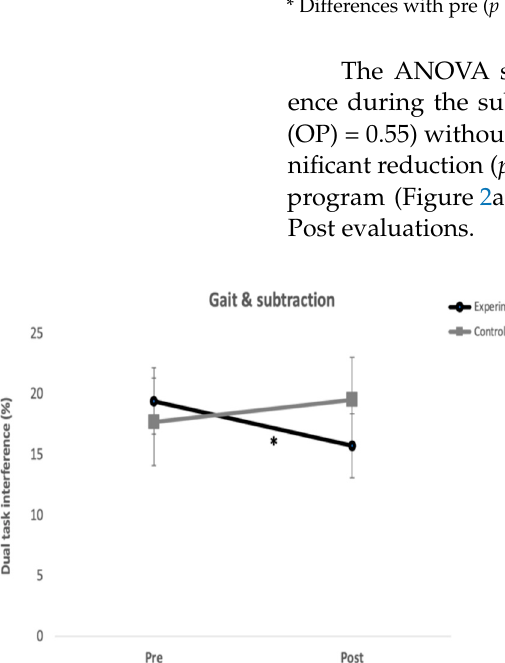
* Differences with pre ( p < 0.05). # Differences with experimental group ( p < 0.05).